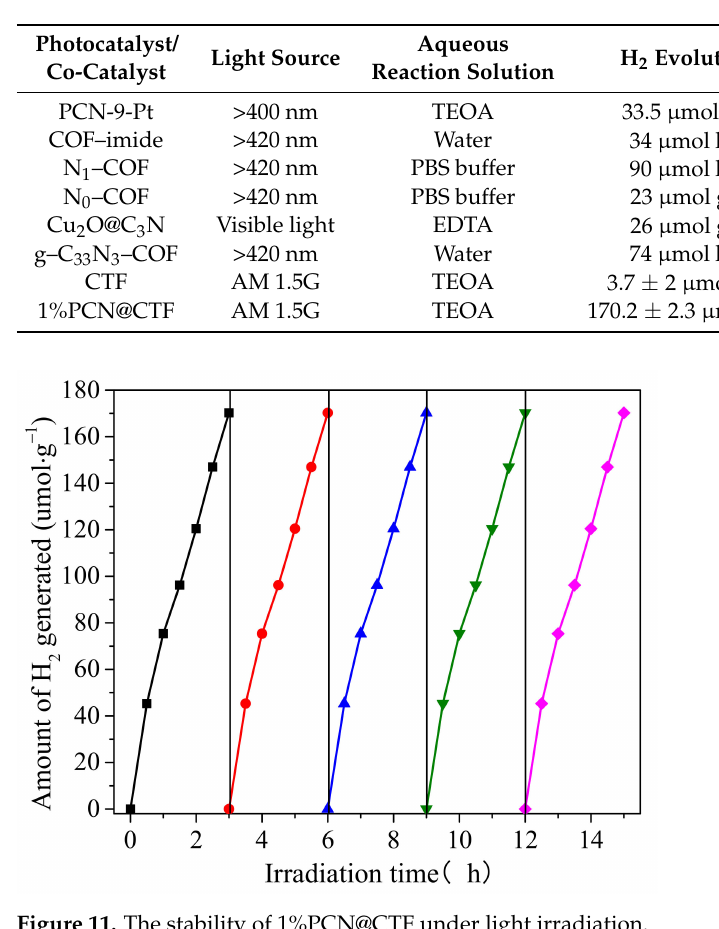
Figure 11. The stability of 1%PCN@CTF under light